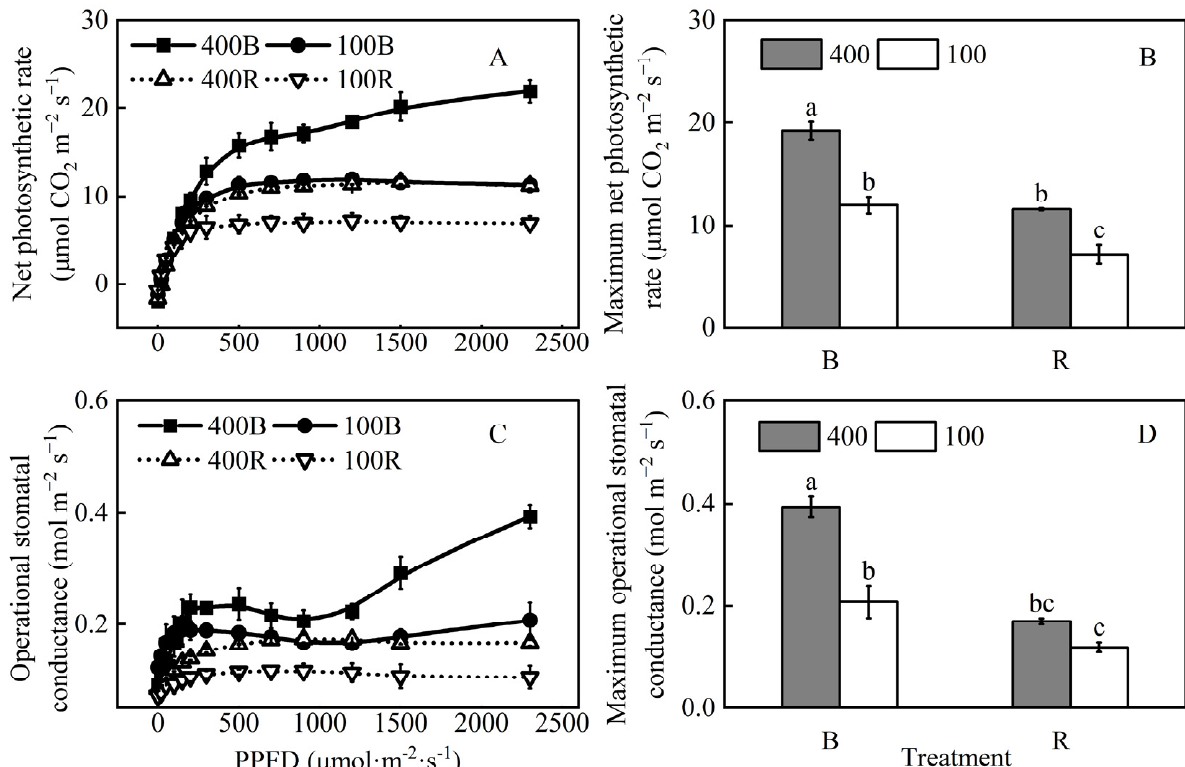
Figure 4. Effects of different light treatments on photosynthetic parameters. ( A , C ) The response curves of net photosynthetic rate and operational stomatal conductance (g op ). ( B , D ) The maximum net photosynthetic rate and operational maximum stomatal conductance (g opmax ). 400 B and 100 B denote blue light with 400 µ mol m − 2 s − 1 and 100 µ mol m − 2 s − 1 , respectively. 400 R and 100 R denote the red light with 400 µ mol m − 2 s − 1 and 100 µ mol m − 2 s − 1 , respectively. The mean ± SE is expressed in each value. Different lowercase letters indicate significant differences between treatments ( p ≤ 0.05).